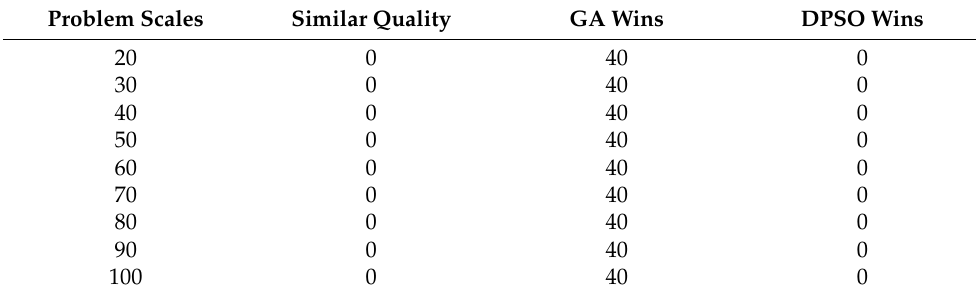
Table 4. Average difference in the distance traveled under the GA and DPSO algorithm. Problem Scales